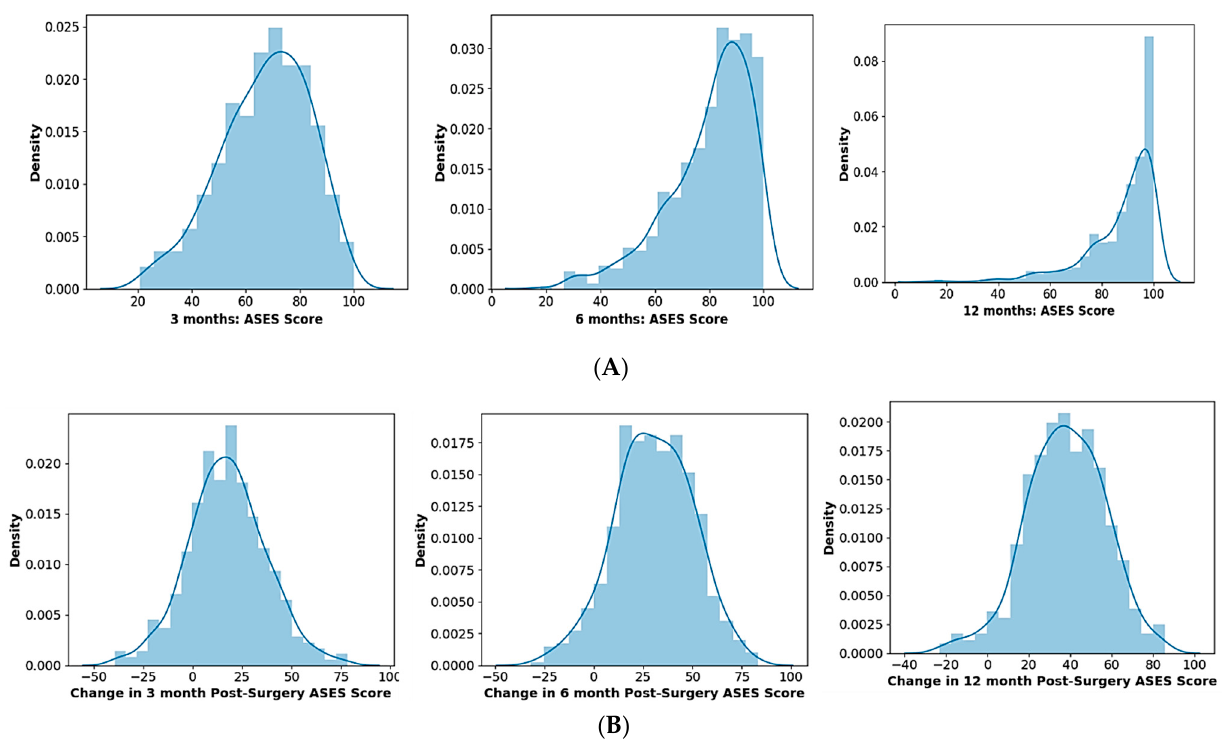
Figure 2. Histogram of ( A ) 3-, 6-, and 12-month post-operative ASES scores and ( B ) change in 3-, 6-, and 12-month post-operative ASES scores compared to pre-operative ASES score.